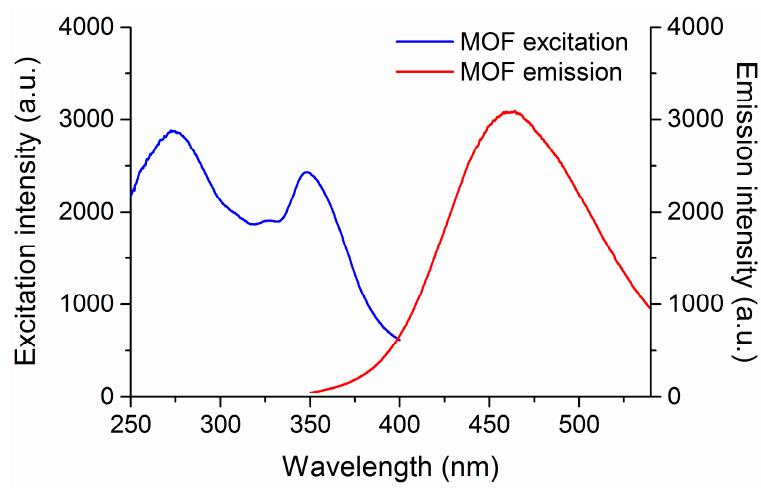
Figure 7. Photoluminescence spectra ( λ exc = 280 nm) and excitation spectra ( λ em = 460 nm) of [Zn 2 (bpdc) 2 (bpee)] powder deposited by soft-imprinting.